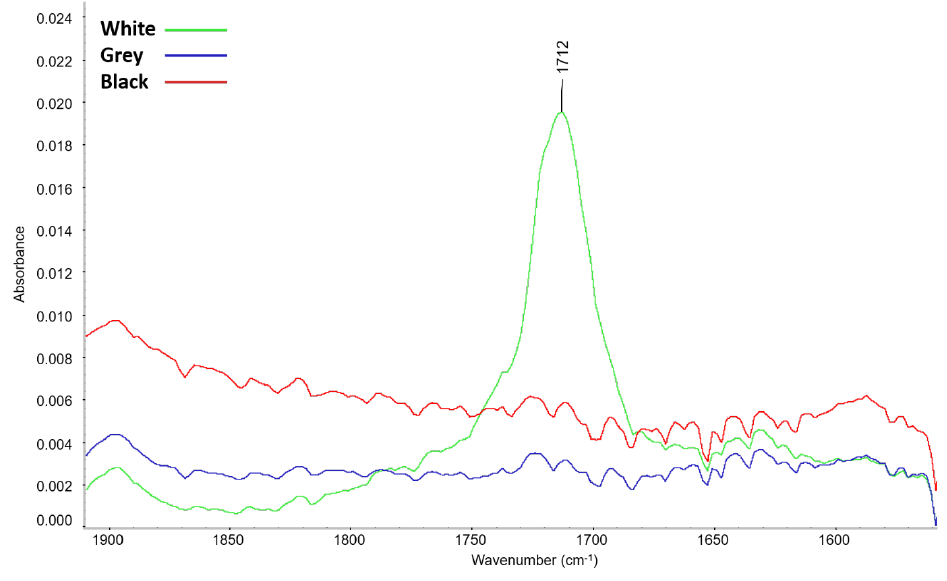
Figure 5. Details of the 1900–1550 cm − 1 range of ATR-FTIR spectra of the tested PE foams after artificial aging.